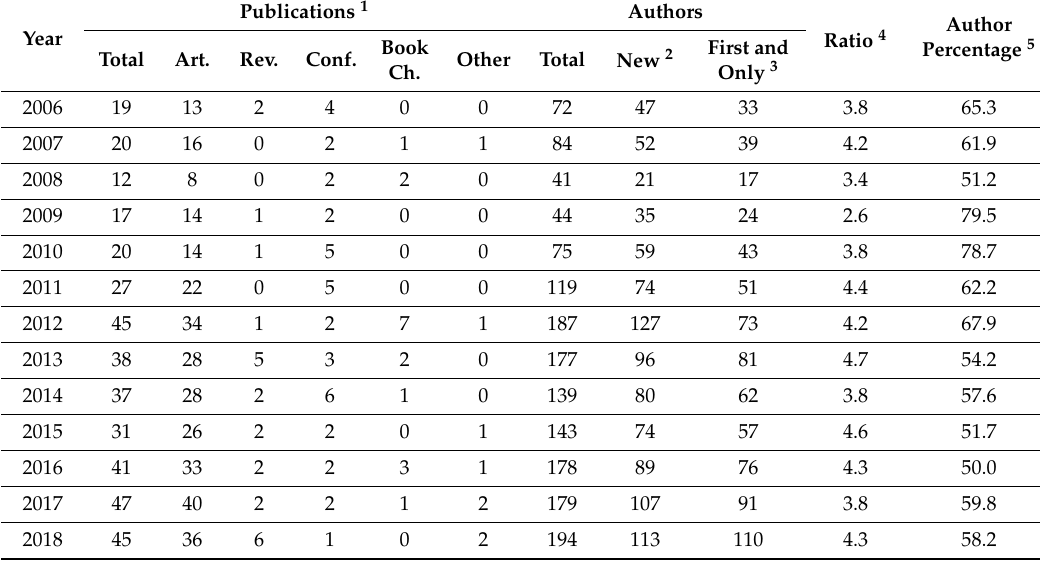
Table 1. Scopus search results for the time period 2006–2018, covering 399 publications out of a total of 731. Table for all years (1965–2018) can be found in